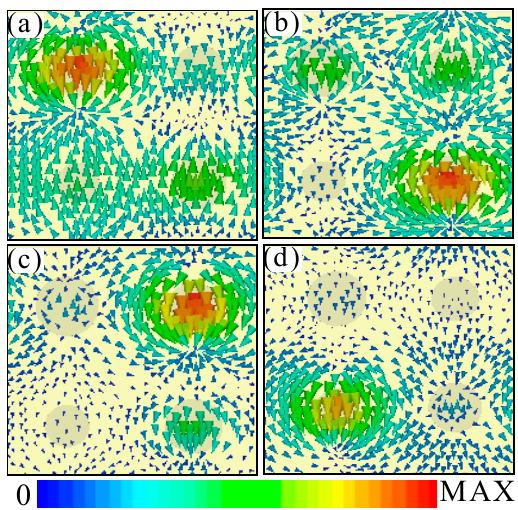
Figure 6. The distributions of surface current in the unit-cell nanostructure of the quad-band PPA at different resonance frequencies: ( a ) f 1 = 433.5 THz, ( b ) f 2 = 456 THz, ( c ) f 3 = 482 THz, and ( d ) f 4 = 504.5 THz.